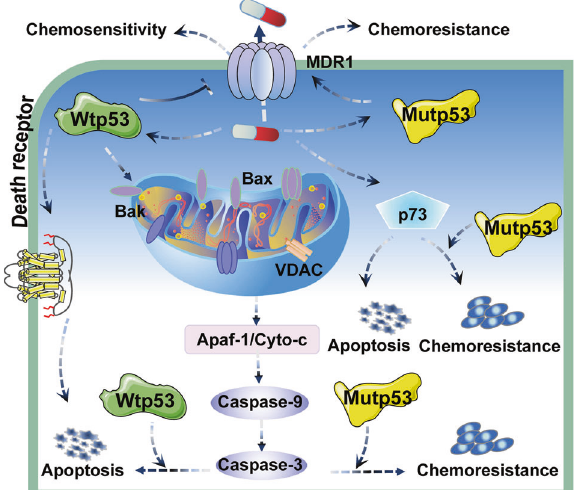
Fig. 5 Schematic representation of the mechanism of mutp53 in chemotherapy. Expression of mutp53 is positively correlated with increased resistance to chemotherapy in different